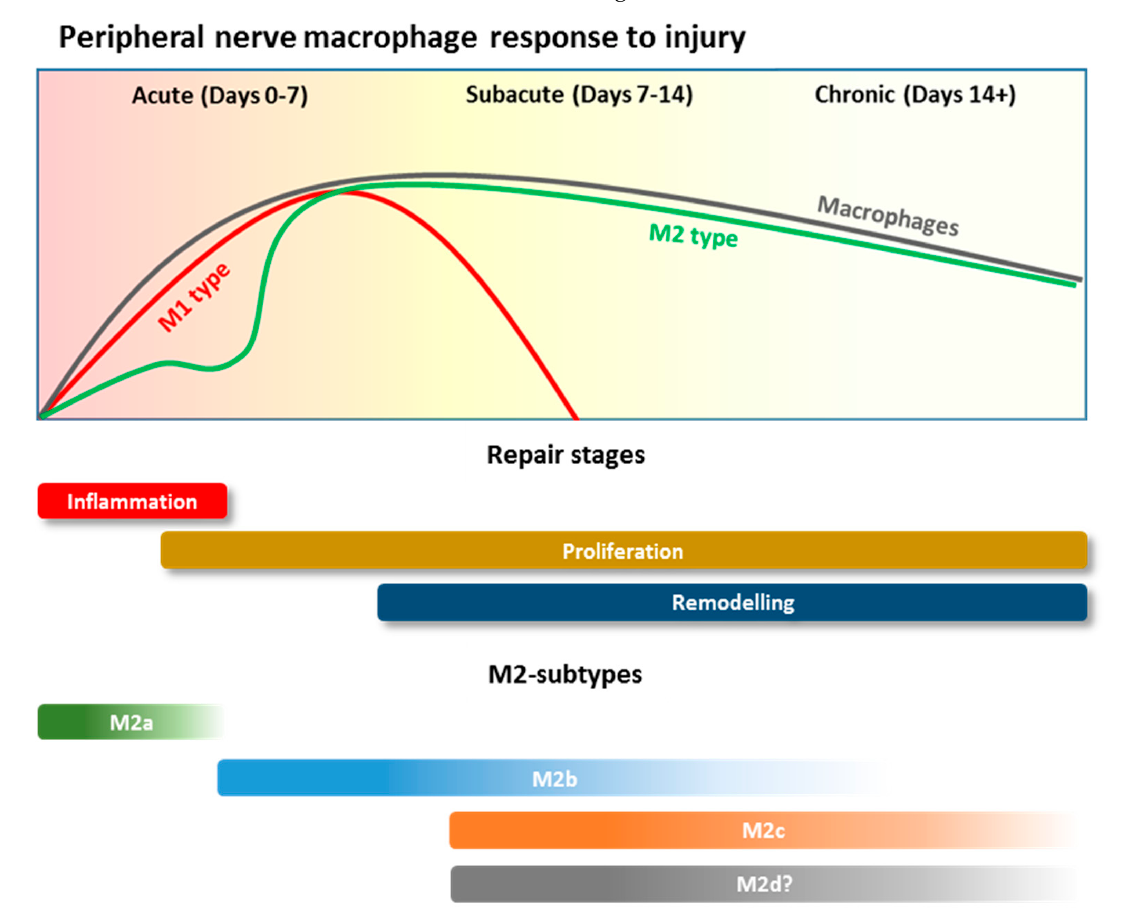
Figure 2. Temporal changes in macrophage phenotype during PNI and repair.